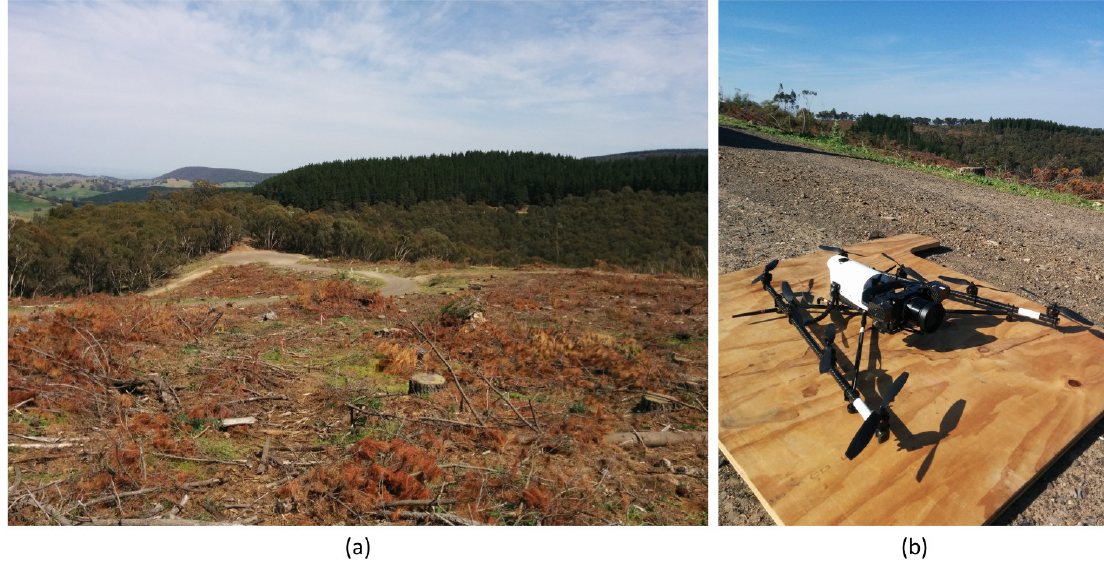
Figure 1. ( a ) Post-harvest residue at fieldwork site at Canobolas State Forest. ( b ) Falcon-8 UAV used to collect airborne datasets during